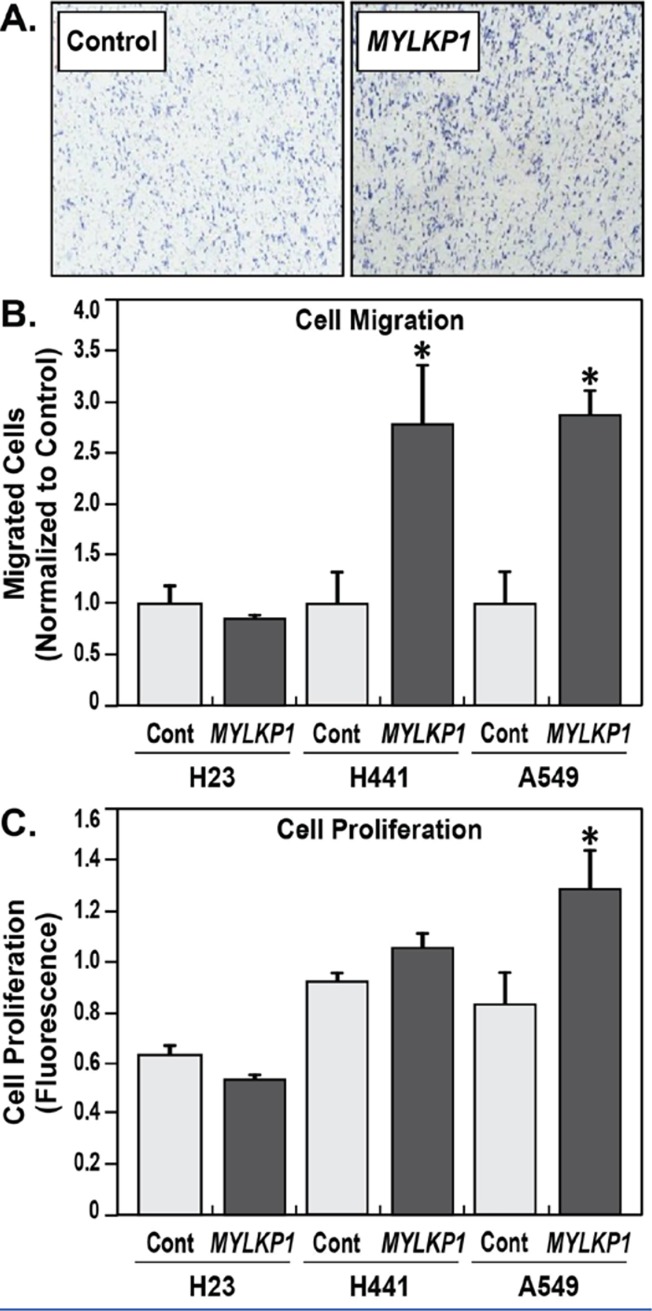
MYLKP increased cell proliferation and cell migration in lung cancer A549 and H441 cell lines.A. A549 and H441 cells transfected with MYLKP migrated more through a porous membrane significantly, compared to controls (*p<0.05). B. In A549 and H441 human lung adenocarcinoma cells, there was more proliferation in MYLKP transfected cells compared to controls (*p<0.05). C. MYLKP was transfected into lung cancer A549 and H441 cell lines, compared with cells transfected with empty vectors.